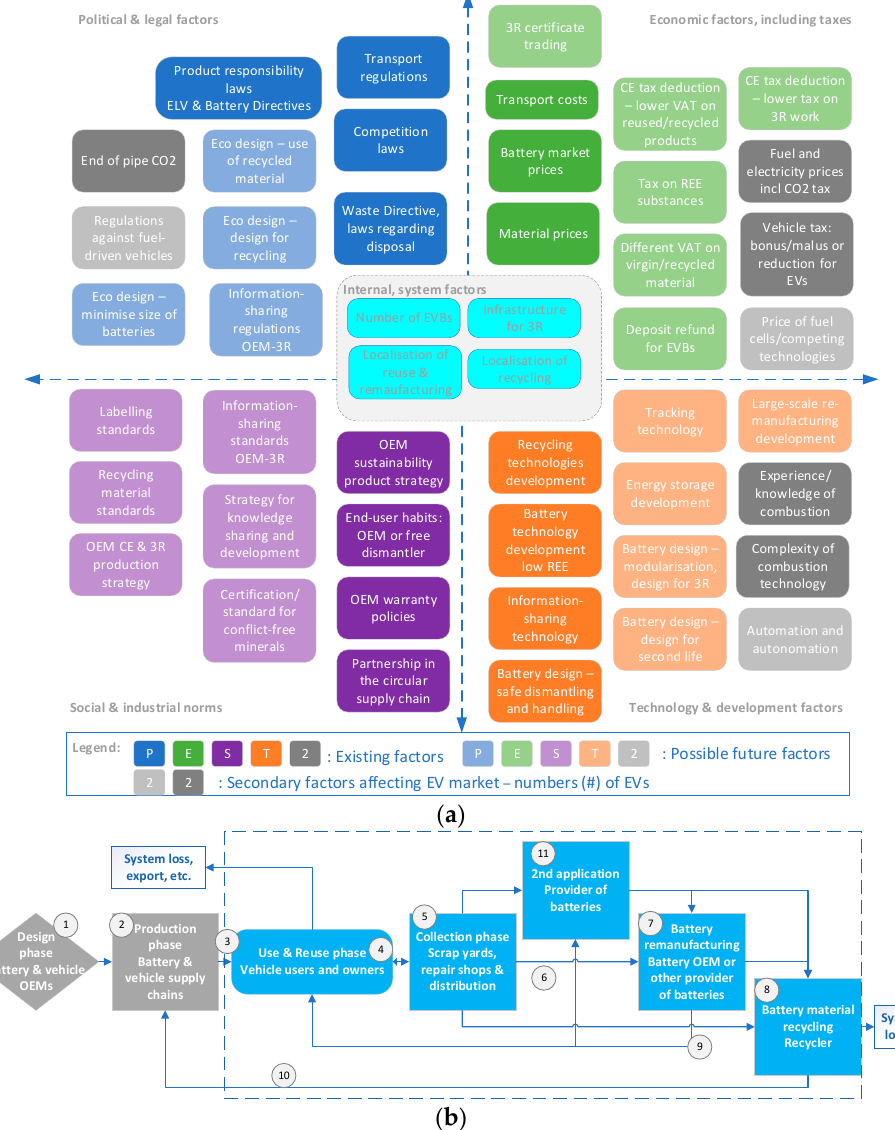
Figure 2. Summary of the results: ( a ) summary of the PEST analysis (political, economic, social and technological factors); ( b ) overview of where each of the factors influences the system. The numbers are given for each factor in Table A1 in Appendix A.